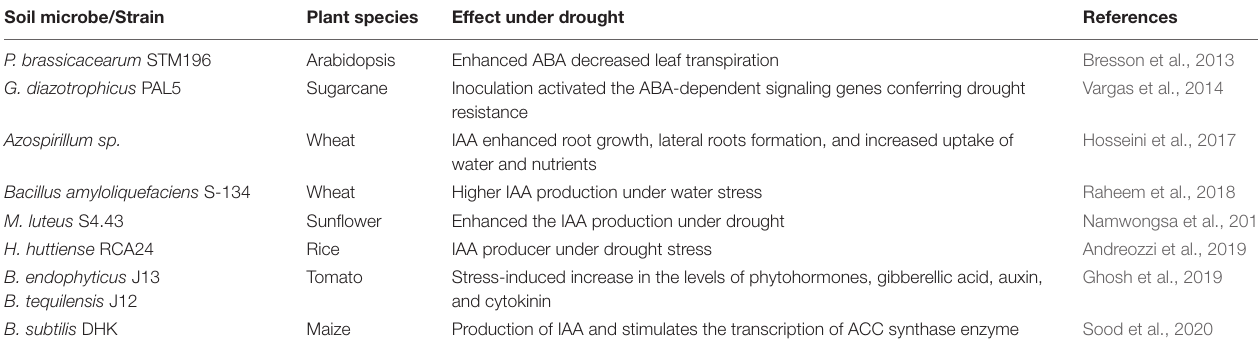
TABLE 5 | Improvement in phytohormone production by PGPR under drought stress.